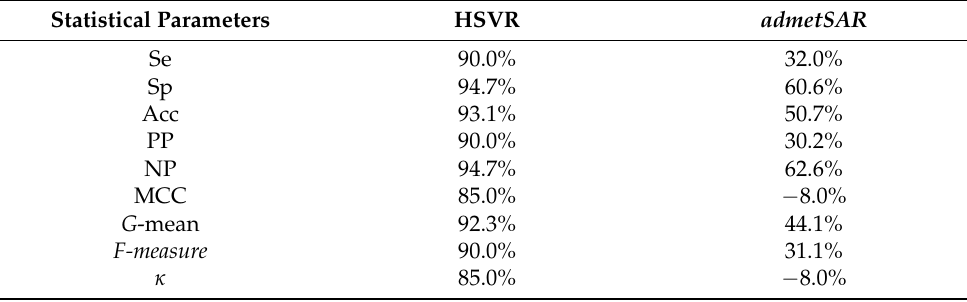
Table 6. Statistical parameters of qualitative predictions by HSVR and admetSAR . Statistical